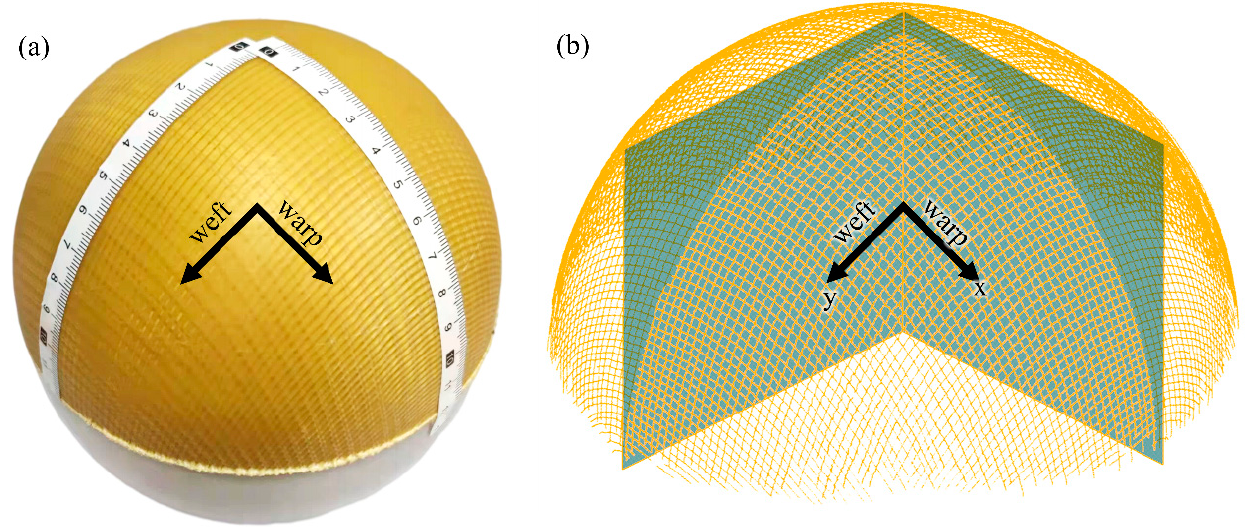
Figure 11. Accuracy evaluation of yarn space: ( a ) manually measuring yarn space; ( b ) obtaining the yarn space of the scanned data.